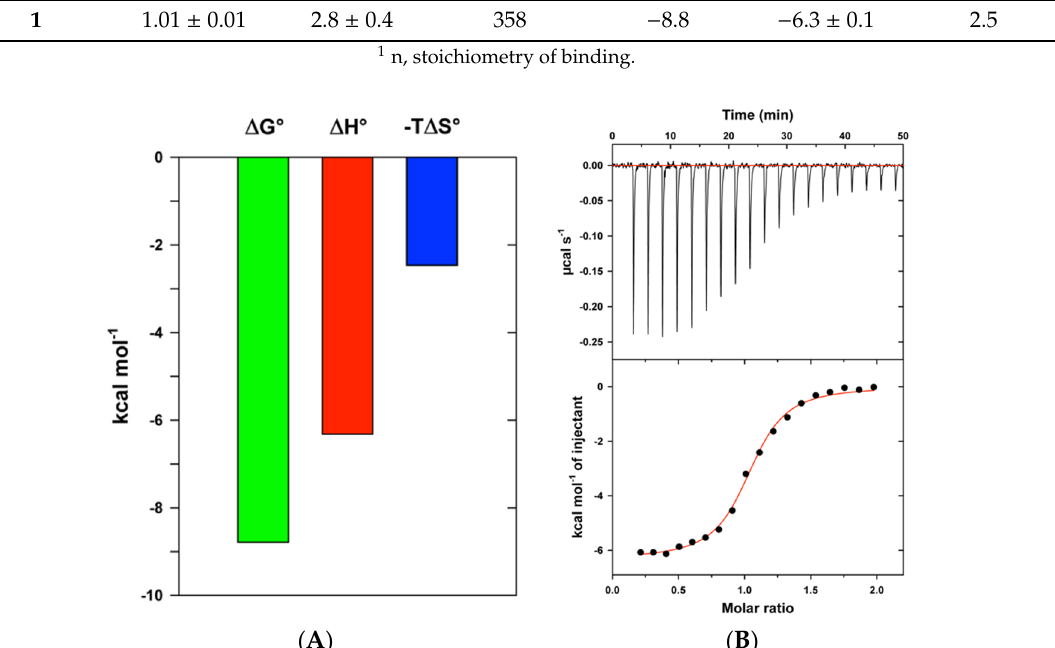
Figure 2. ( A ) VIM-2 binding energetics of compound 1 . Data are from Table 5. ( B ) Isothermal titration calorimetry of VIM-2 by compound 1 at 25 °C. Upper panel: exothermic microcalorimetric trace of compound injections into VIM-2 solution (18.7 μ M). Lower panel: Wiseman plot of heat releases versus molar ratio of injectant/protein in the cell and nonlinear fit of the binding isotherm for n equivalent binding sites. The binding enthalpy corresponds to the amplitude of the transition curve, K a is derived from the slope of the transition and the stoichiometry n is determined at the transition midpoint.